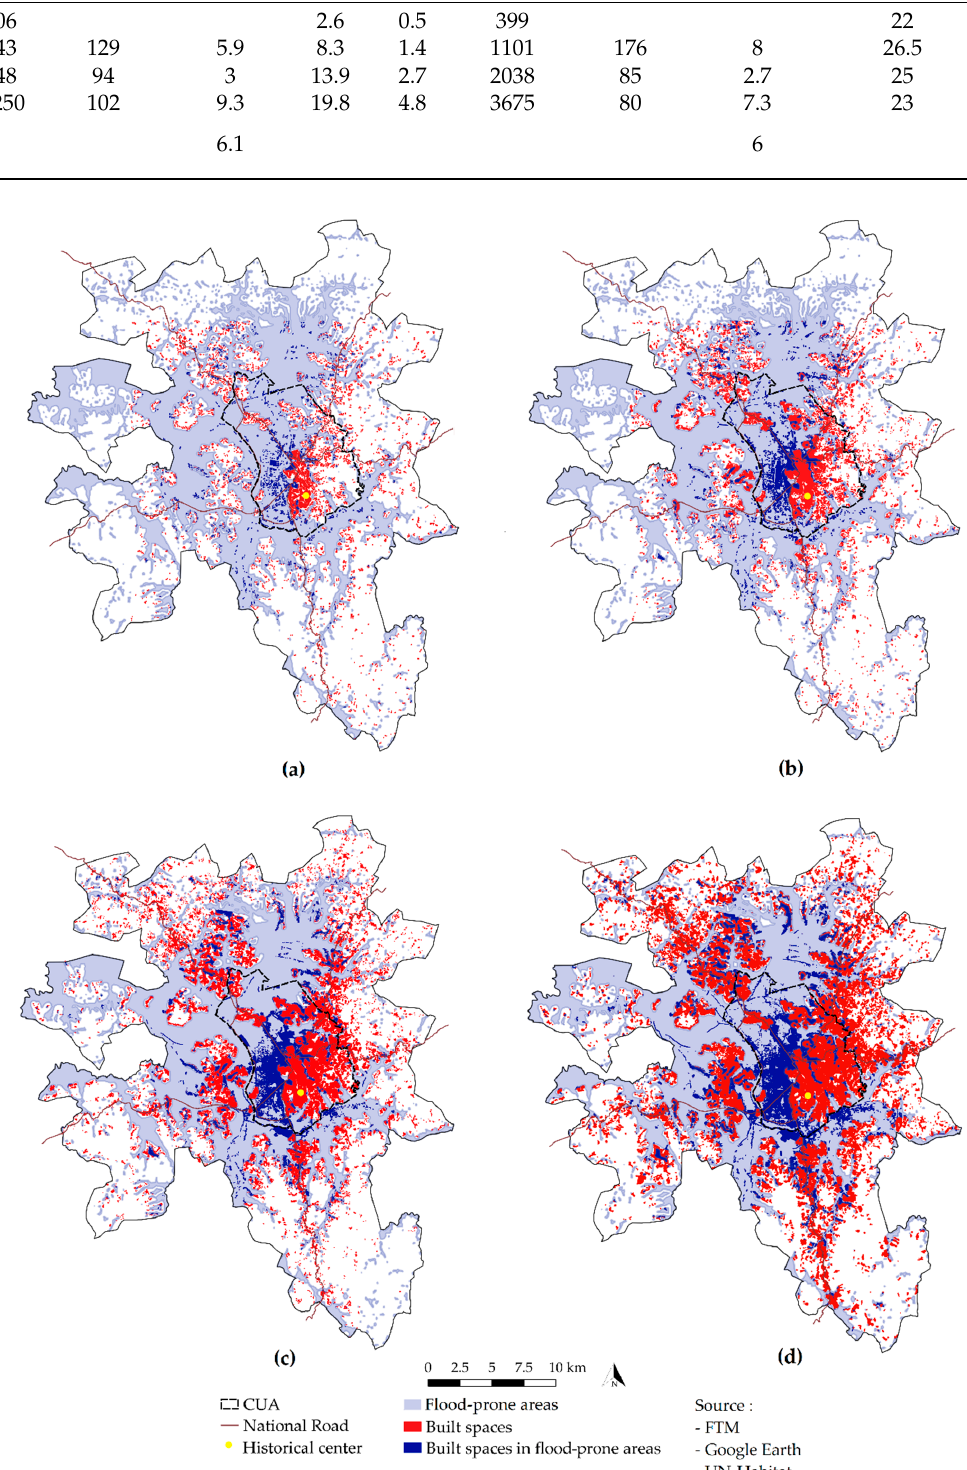
Figure 9. Urbanized cells in flood-prone zones: ( a ) 1953; ( b ) 1975; ( c ) 2006; ( d ) 2017. From the 1960s, the period of independence, backfilling continued in the flood plain (Figures 8 and 9). Several new urban areas were built, and this did not protect the city from flooding. Urbanization continued until 1975, with approximately 2330 ha more of built areas than in 1953, and built areas then covered 5.4% of the agglomeration. The in- crease compared to 1953 is estimated at 129%, an annual increase of 5.9% (Table 2). Inside the CUA, built areas grew considerably and covered 25.5%. These are divided into two distinct parts: to the east toward the elevated areas and to the west in the flood plain (Fig- ure 9). Built areas in flood-prone zones then represented 8.3% of the CUA, a sharp increase compared to the situation in 1953. In peripheral municipalities, urbanization mainly oc- curred through the filling of voids and the densification of existing areas. In addition to this urban expansion at the agglomeration level, the share of built areas located in flood- prone zones increased very rapidly. Compared to 1953, built areas located in flood-prone zones increased by 176%, an annual increase of 8%, covering 26.5% of the entire built area at the agglomeration level (Table 2). From 1975 to 2006, urban expansion progressively shifted toward peripheral munic- ipalities, especially in the neighboring municipalities of the CUA (Figure 8). It was guided by national roads and showed five centers of urban growth. In the CUA, urban consoli- dation continued and densified the area to the east and northwest. Built areas then occu- pied 48.2% of the CUA. In the whole agglomeration, between 1975 and 2006, the built areas increased by 94%, corresponding to an annual increase rate of 3%. The built areas then occupied 10.5% of the agglomeration, i.e., 8048 ha. It can be seen from Table 2 that 25% of built areas were then located in flood-prone zones. This is equivalent to an 85% increase compared to the situation of 1975, i.e., a 2.7% yearly increase over the period 1975–2006 (Table 2). Between 2006 and 2017, urban expansion further intensified, especially in peripheral areas. Constructions was dispersed in areas far from the CUA. Approaching the CUA, the urban fabric became denser, especially in the northwest and the south (Figure 8). In the CUA, despite high density, urbanization continued to progress, to a large extent at the